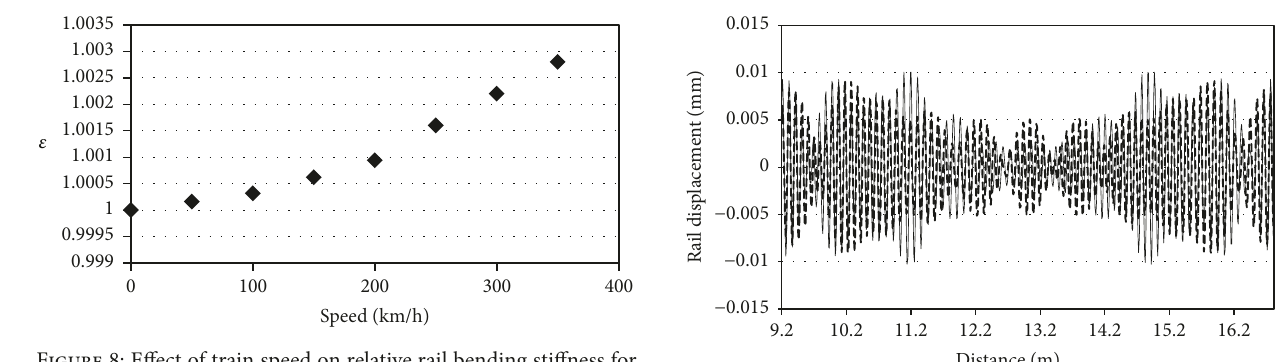
Figure 8: Effect of train speed on relative rail bending stiffness for the Timoshenko and Euler-Bernoulli beams ( 𝜀 = 𝐸𝐼/𝐵 sub ).